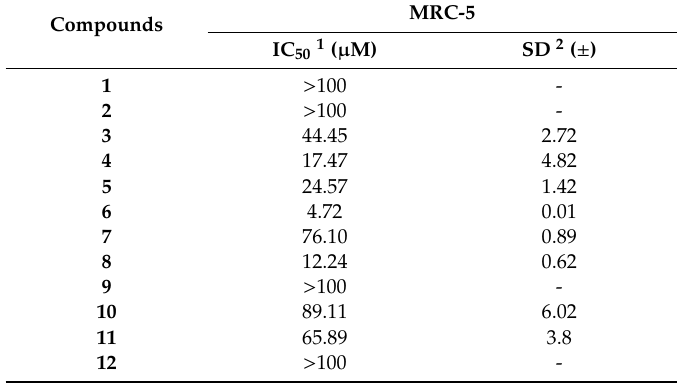
Table 5. Cytotoxic activity of tested compounds against MRC-5 human embryonal lung fibroblast cell